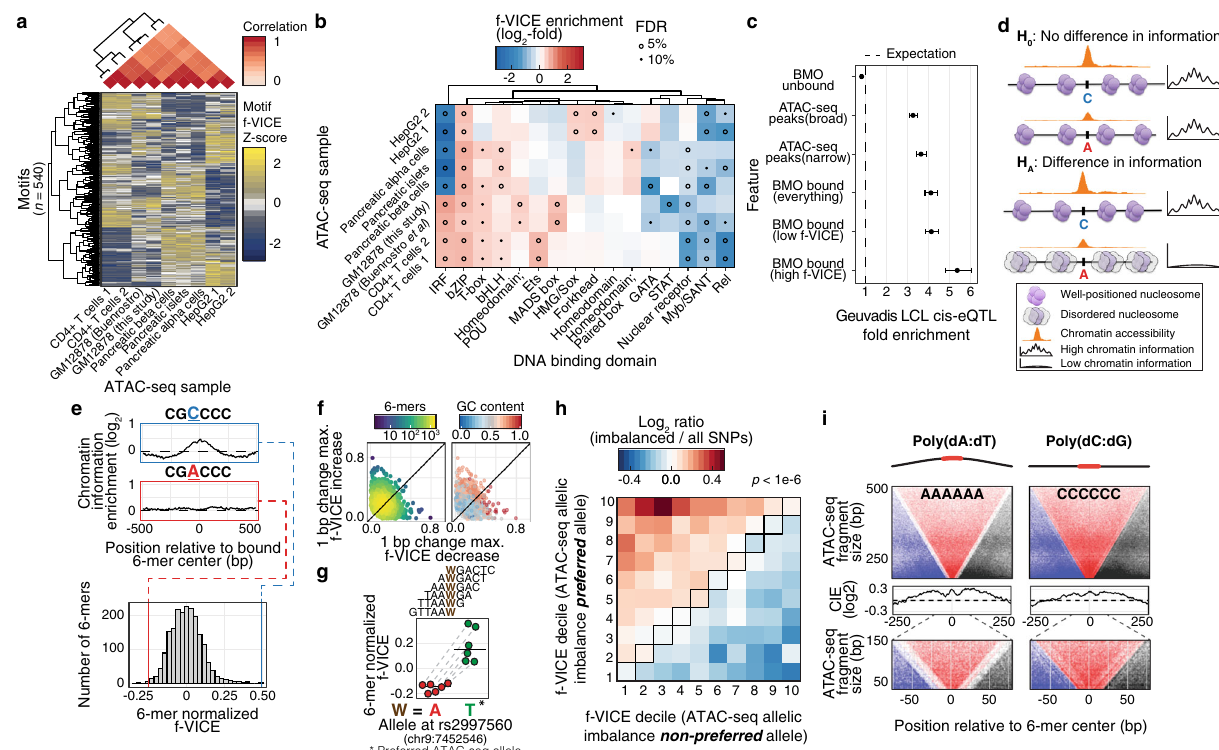
Fig. 3 The chromatin information landscape of human tissues. a Hierarchical clustering of f-VICE Z-scores. b f-VICE enrichments across DBDs. c , LCL cis - eQTLs enrichments ( n = 2,743 lead SNPs). Central dot, effect size mean; error bars, effect size SD. d Hypothesis schematic. e Upper: Two 6-mers with 1-bp difference in sequence. Lower: pancreatic islets 6-mer normalized f-VICE distribution. f Range of f-VICE differences associated with 1-bp difference in 6- mer sequence. g Predicted f-VICE change associated with rs2997560 in pancreatic islets. Horizontal bars, median. h Log 2 ratio of f-VICE decile changes associated with the preferred and non-preferred alleles of imbalanced SNPs versus all tested SNPs in pancreatic islets. i CIE patterns at DNA 6-mers with poly(dA:dT) and poly(dC:dG) Fig. 2h, Supplementary Fig. 22a). The direction of CIE asymmetry was signi fi cantly correlated with the direction of the nearest TSS relative to each motif instance (Spearman ’ s ρ = 0.66, p = 3.34e- 20; Supplementary Fig. 22b). To determine if asymmetric CIE was an artifact of TSS proximity, we calculated CIE asymmetry separately for TSS-proximal ( ≤ 1 kb) and TSS-distal ( ≥ 10 kb) motif instances. The TSS-distal and TSS-proximal CIE asym- metry directions agreed signi fi cantly more than expected by chance (111/150, binomial test p = 3.38e-9, Fisher exact test p = 2.80e-5; Supplementary Fig. 22c-d), suggesting that CIE asym- metry is intrinsic to the TF motif. The magnitude of asymmetry was higher in TSS-proximal motifs (Supplementary Fig. 22d), suggesting that TSS proximity ampli fi es TF CIE asymmetry.